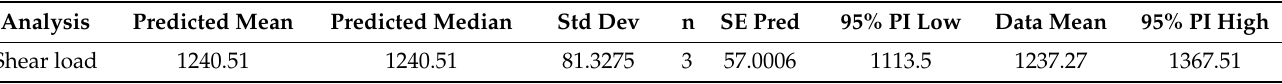
Table 5. Confirmation test of the DoE. Two-sided Confidence =